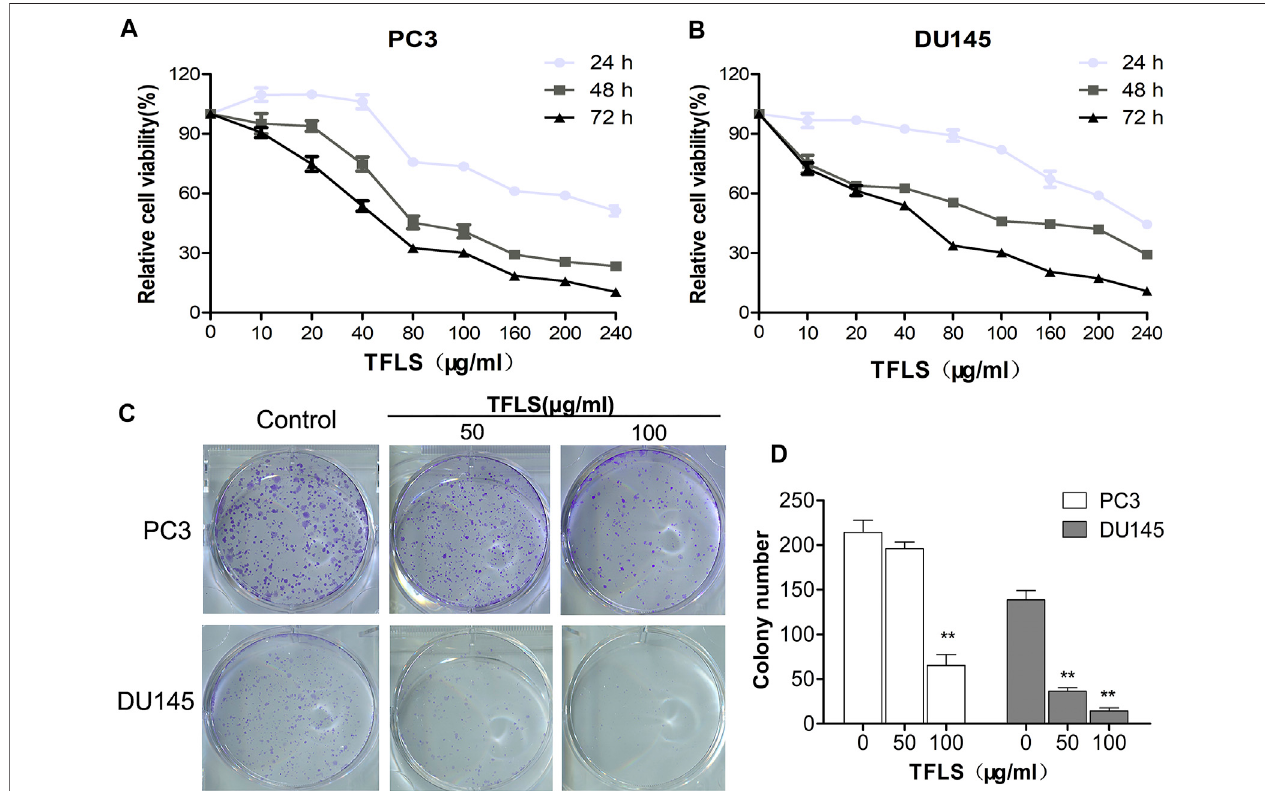
FIGURE2| TFLSinhibitedtheproliferationofPCacells. (A,B) PC3andDU145cellsweretreatedwithdifferentconcentrationsofTFLS(0 – 240 μ g/ml)for24,48and 72 h,andcellviabilitywasdetectedbytheMTSassay. (C) ThecolonyformationofPC3andDU145cellstreatedwithTFLSfor8 days. (D) Quanti fi cationofthenumberof colonies of PCa cells. The number of colonies was expressed by mean ± SEM, compared with the control group: * p < 0.05; ** p < 0.01.